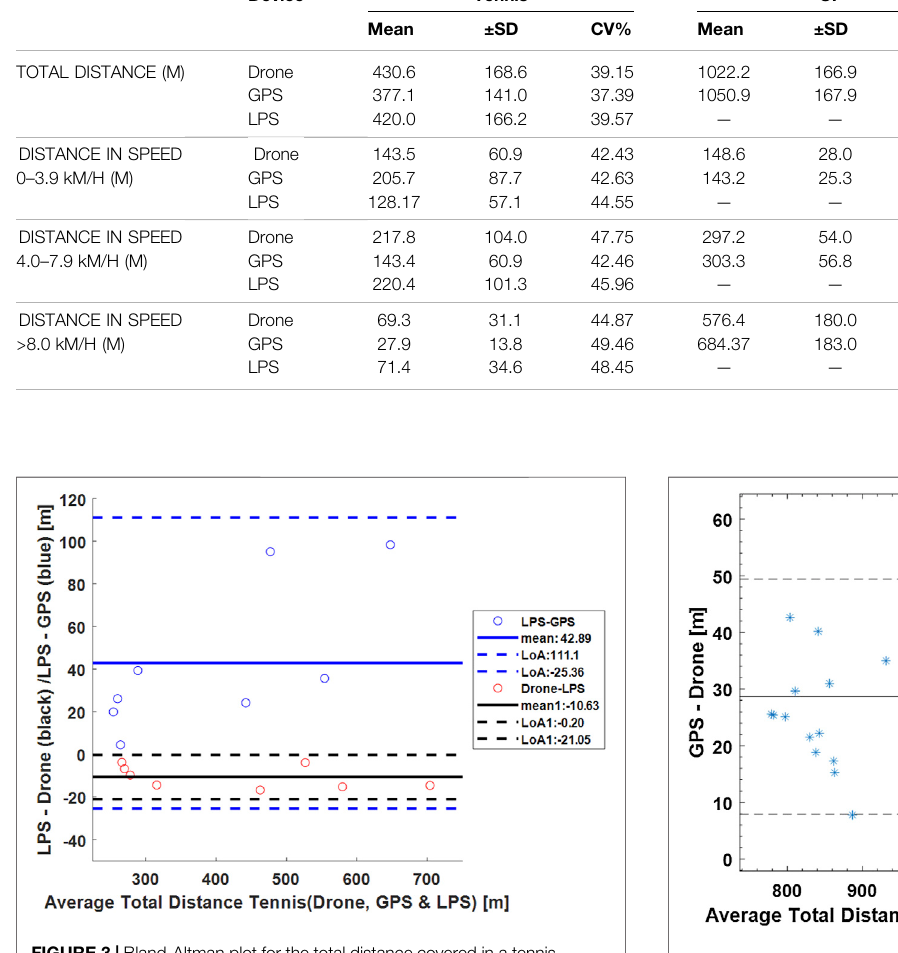
FIGURE 4 | Bland-Altman plot for the total distance covered in an Ultimate Frisbee match measured by the drone and GPS. Dashed lines show the limits of agreement (7.93 and 49.41), and the continuous line shows the mean 28.87